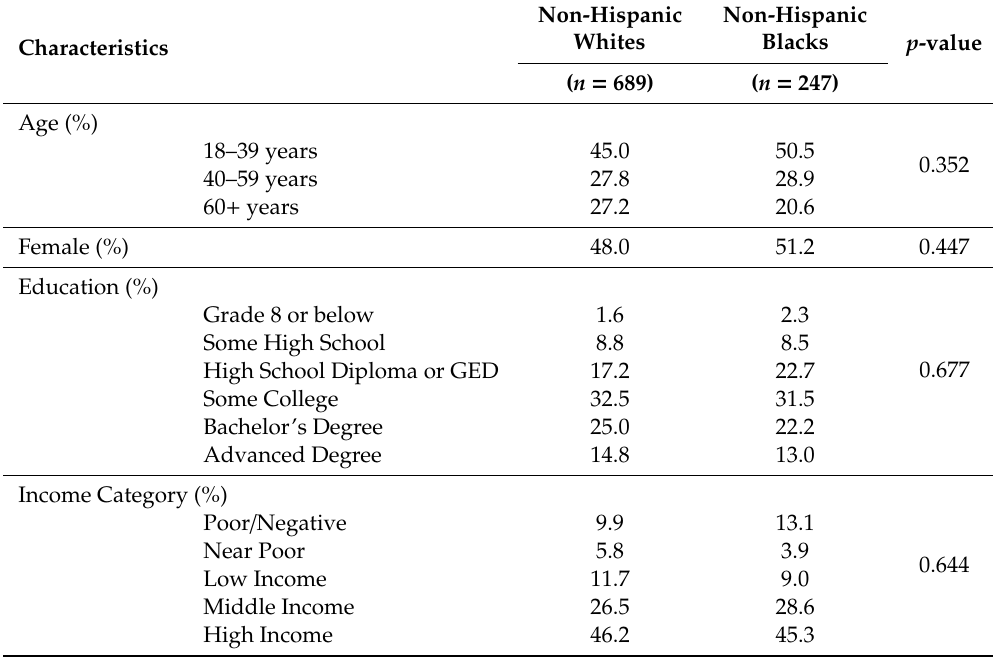
Table 1. Demographic and health characteristics of Medical Expenditure Panel Survey respondents living within gentrifying neighborhoods by race,